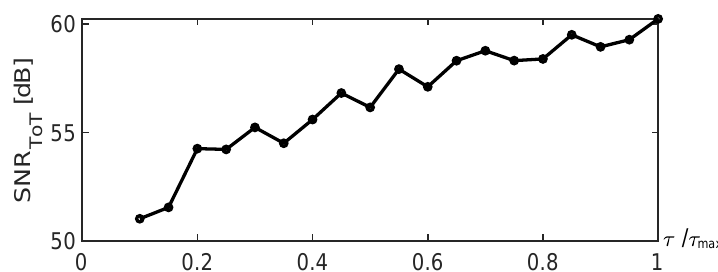
Figure 5. SNR of the ToT signal versus τ of the analog-channel output, for V TH = 0.8 × V p and σ noise =